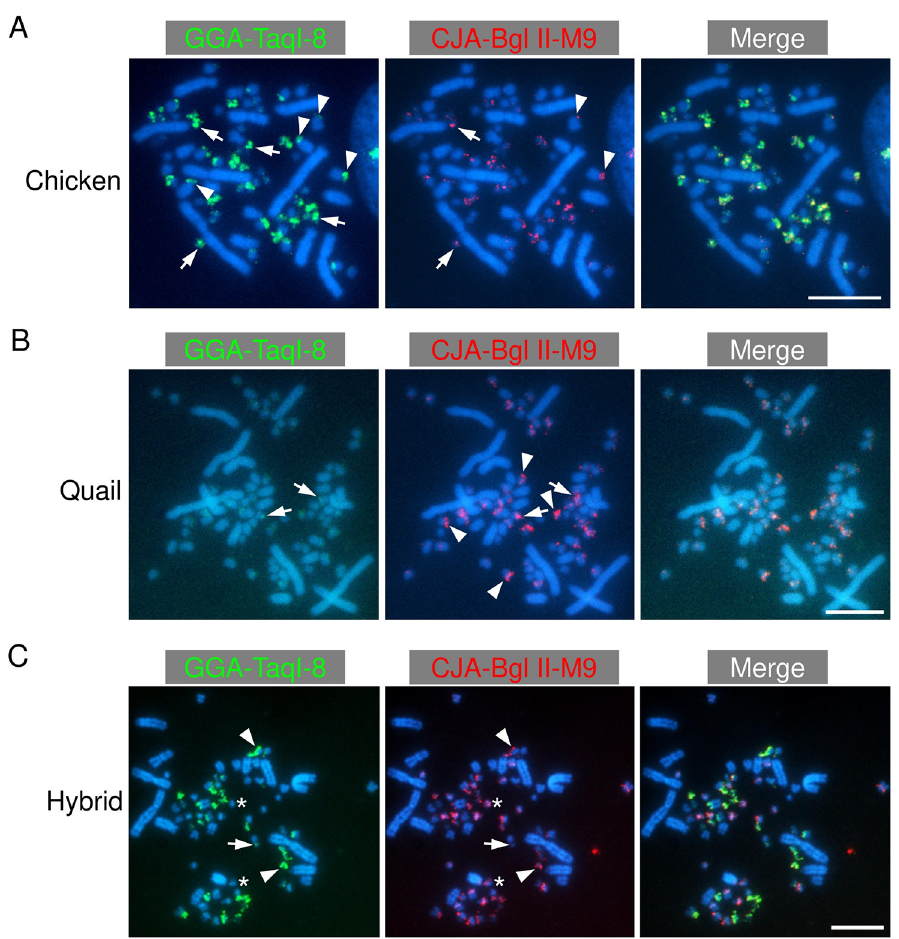
Fig 2. Chromosomal localization of chicken and quail centromeric repetitive sequences in chickens, quail, and their hybrids. Fluorescence-labelled DNA probes of chicken and quail centromeric repeats (GGA-TaqI-8 and CJA-BglII-M9, respectively) were hybridized into chromosome spreads of chickens (A), quail (B), and their hybrids (C). A. GGA-TaqI-8 was localized to almost all microchromosomes (arrows in the left panel indicate representatives) and two pairs of macrochromosomes (arrowheads in the left panel). CJA-BglII-M9 was cross-hybridized into a part of microchromosomes and a few macrochromosomes (arrows and arrowheads, respectively, in the middle panel). B. GGA-TaqI-8 was cross-hybridized into quail chromosomes, which was observed as weak hybridization signals (arrows in the left panels). CJA-BglII-M9 was localized to almost all microchromosomes (arrows and arrowheads in the middle panel). C. Chromosomes that were hybridized only with GGA-TaqI-8 (arrows) and those that were hybridized with both GGA-TaqI-8 and CJA-BglII-M9 (arrowheads) were observed in the hybrid. These were considered as chicken- derived chromosomes. In addition, chromosomes that exhibited hybridization signals of CJA-BglII-M9, with no or weak hybridization signals of GGA-TaqI-8, were observed (asterisks). These were considered as quail-derived chromosomes. Scale bars, 10 μ